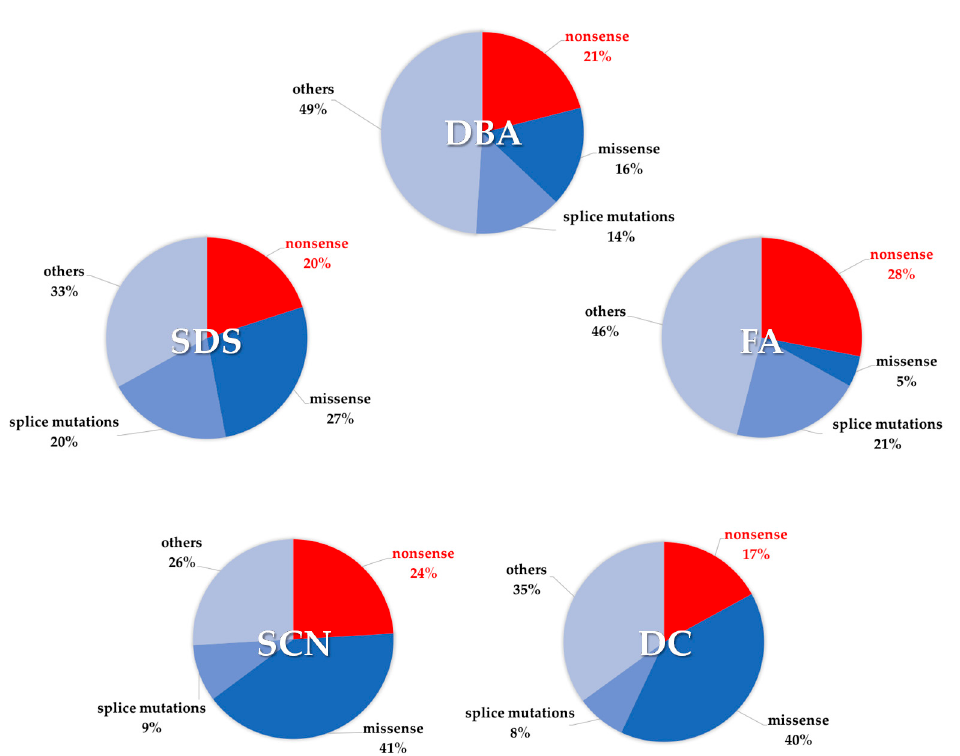
Figure 1. Incidence of nonsense mutations in inherited bone marrow failure syndromes (IBMFS). Percentages have been calculated on the basis of ClinVar database [15]. Only pathogenic and likely pathogenic variants have been taken into account.